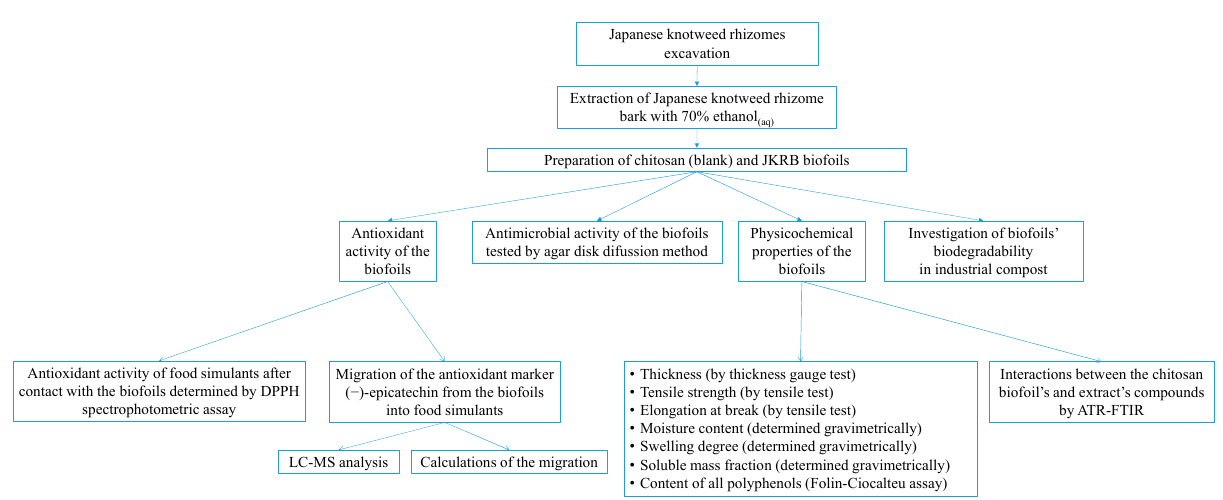
Figure 1. A flow chart of work performed throughout the study.